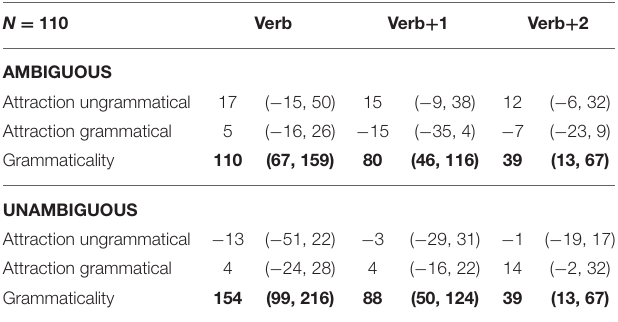
Table 5 | Results of experiment